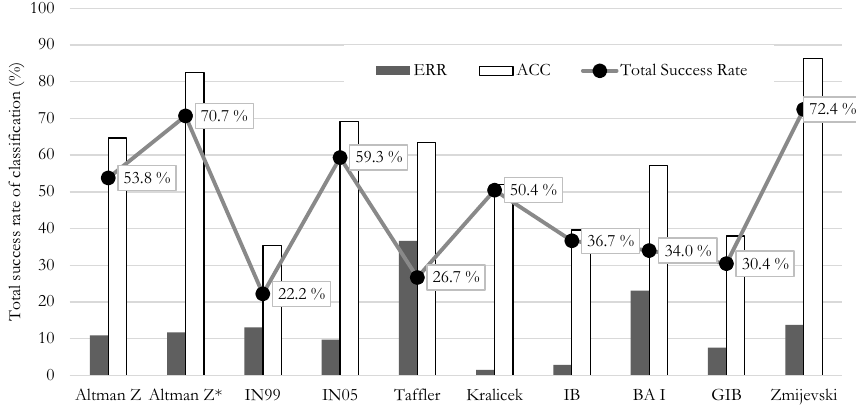
Fig. 2 – Evaluation according to the error rate (ERR), accuracy (ACC) and total success rate of classification. Source: own